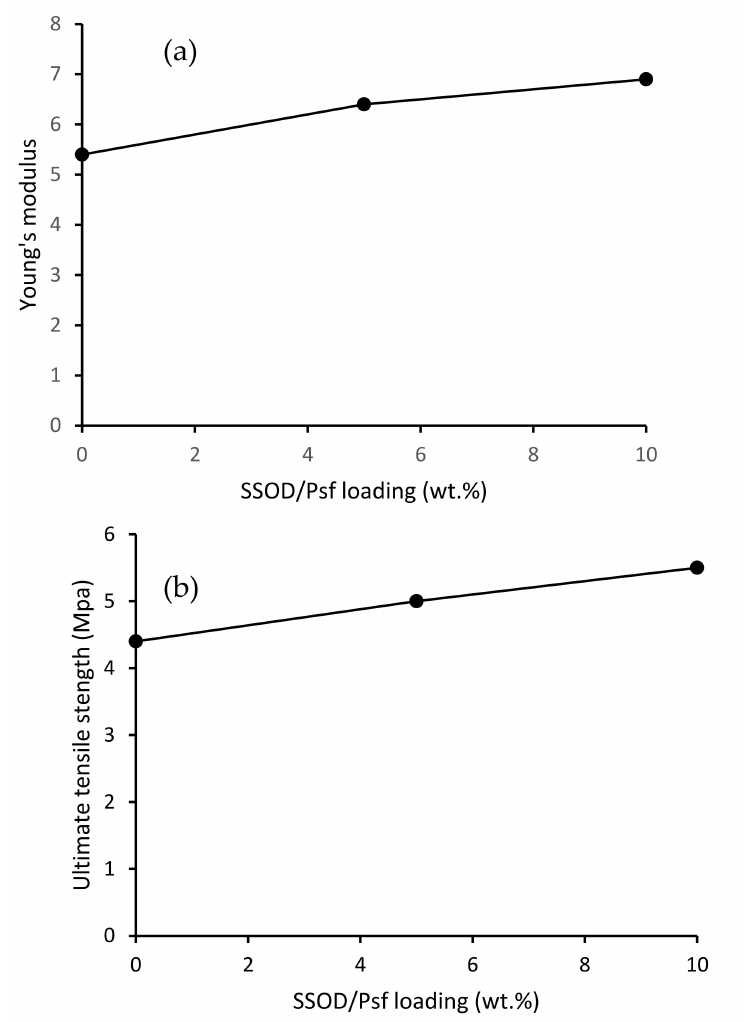
Figure 8. Mechanical properties ( a ) Young’s modulus and ( b ) Ultimate tensile strength.